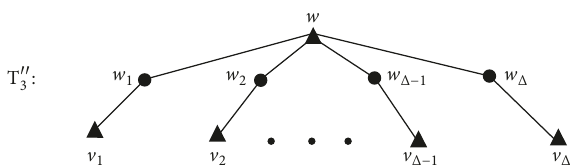
Figure 3: The tree 𝑇 3 with exactly Δ major vertices at distance two to 𝑤 .